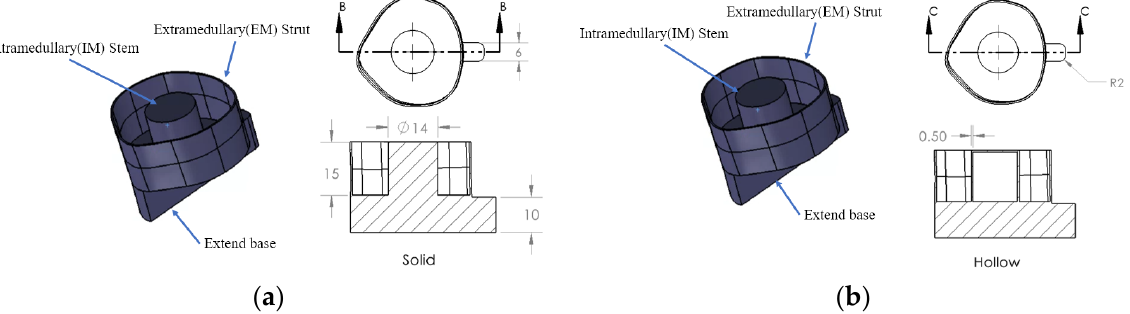
Figure 1. Triangular–shaped implant model and dimension developed based on Patent US20200188140: ( a ) implant with solid IM stem and ( b ) implant with hollow IM stem.